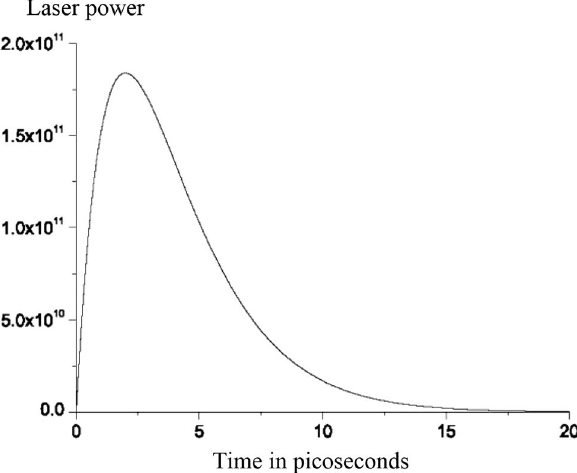
Figure 1. Temporal pro fi le of the laser pulse.